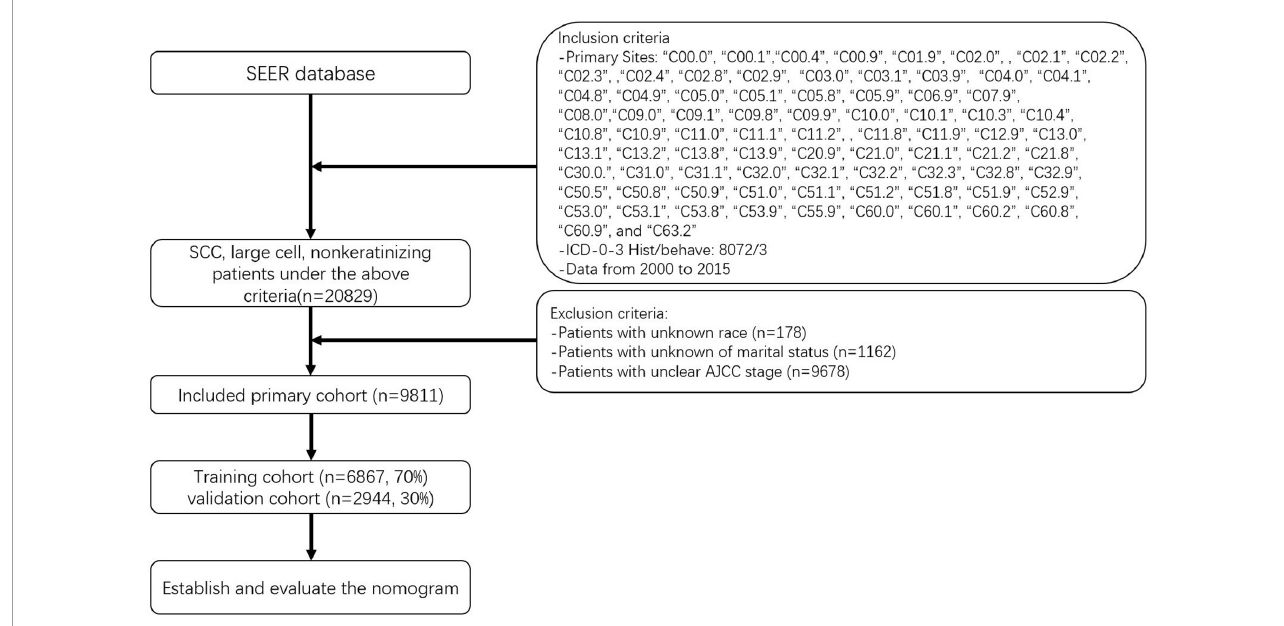
FIGURE1 Flowchart of sample